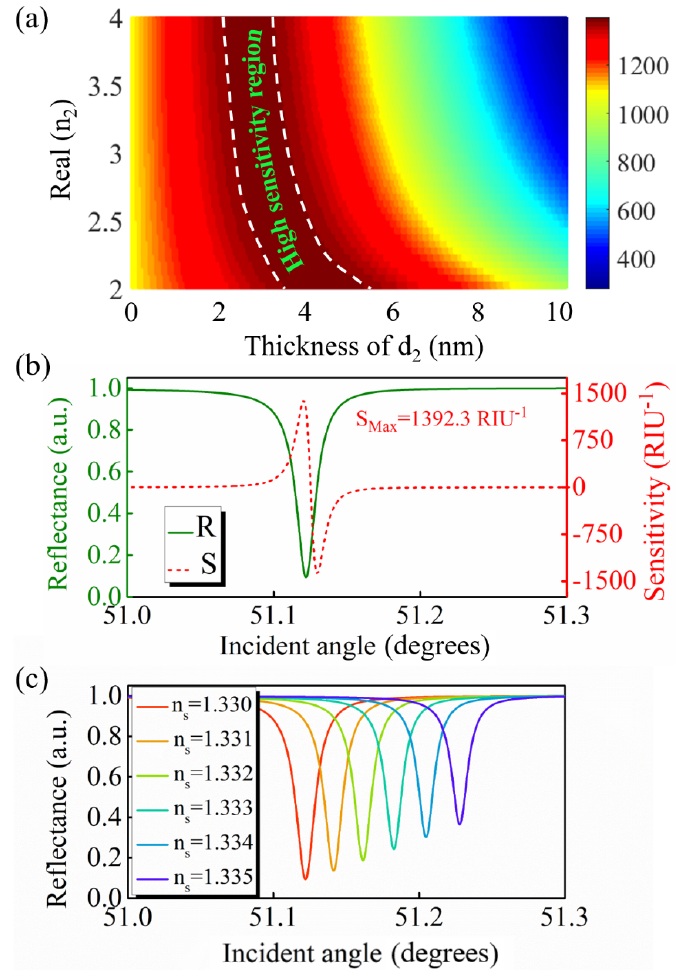
Figure 6. ( a ) Optimizing n 2 and d 2 to obtain the highest sensitivity. ( b ) The resonance signal of the proposed GW − LRSPR sensor and its corresponding sensitivity at d 2 = 3 nm when the high − RI GW layer was silicon. ( c ) Shift of the resonance signal at different RIs of the sensing analytes.